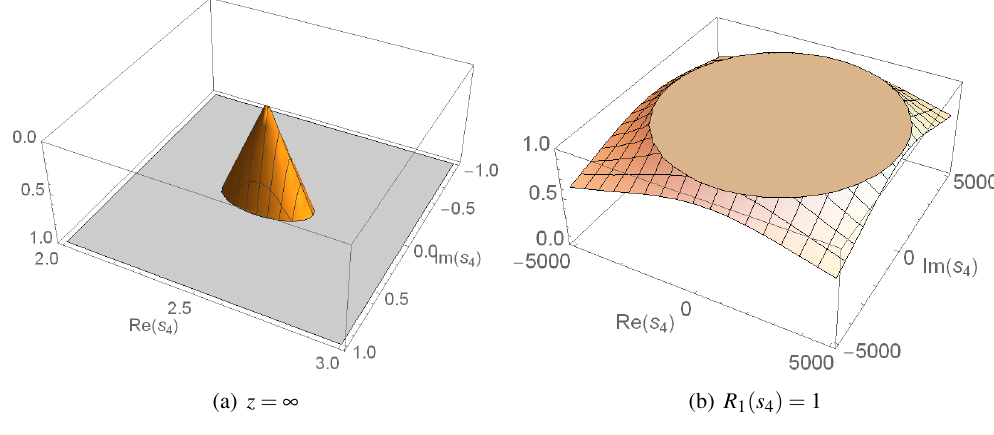
Fig. 4 Stability function of the fixed points z = ∞ and z = 1, for m =